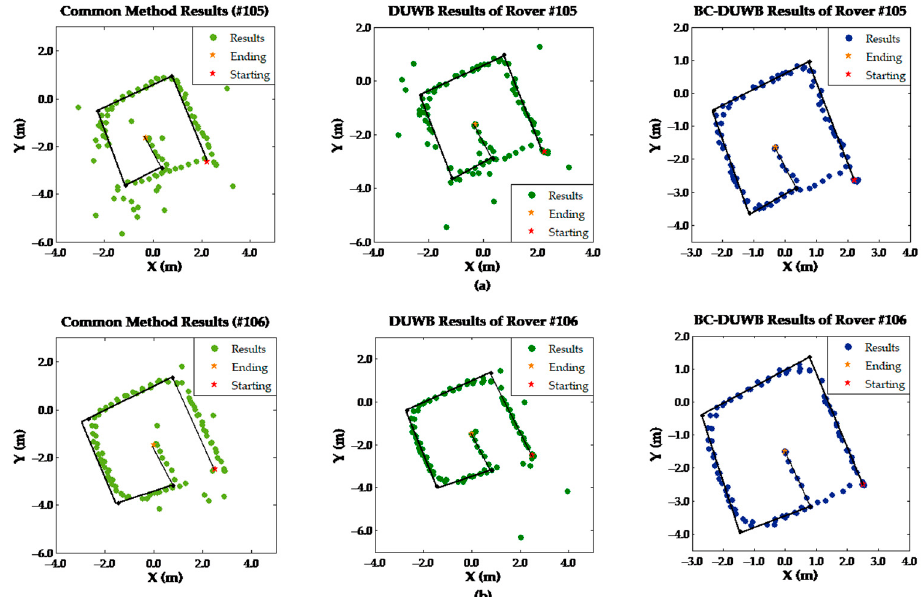
Figure 13. ( a ) The positioning results of rover #105 with different methods (Test 3); ( b ) The positioning results of rover #106 with different methods (Test 3).